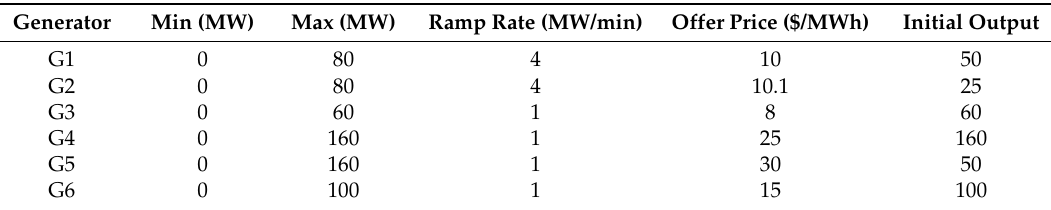
Table 1. Conventional generator characteristics.